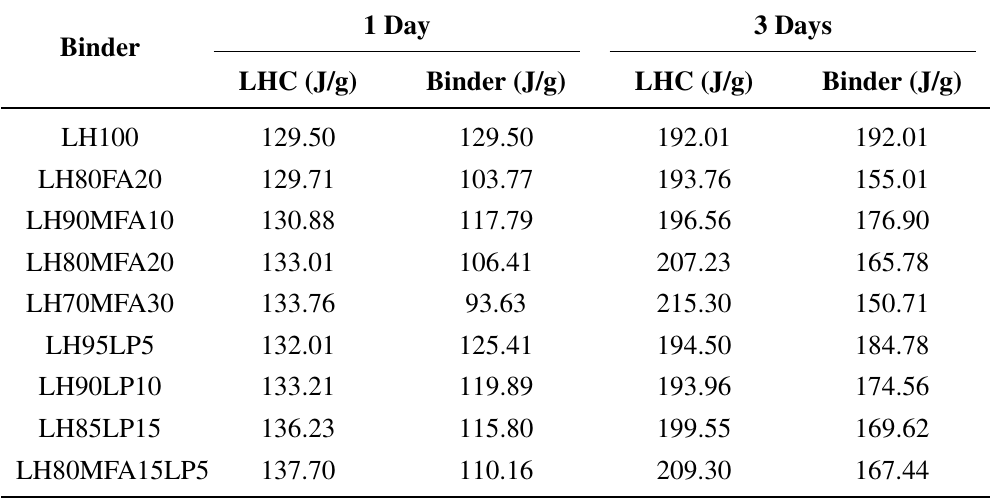
Table 4. Cumulative heat of hydration emitted per g of low-heat cement (LHC) and per g of